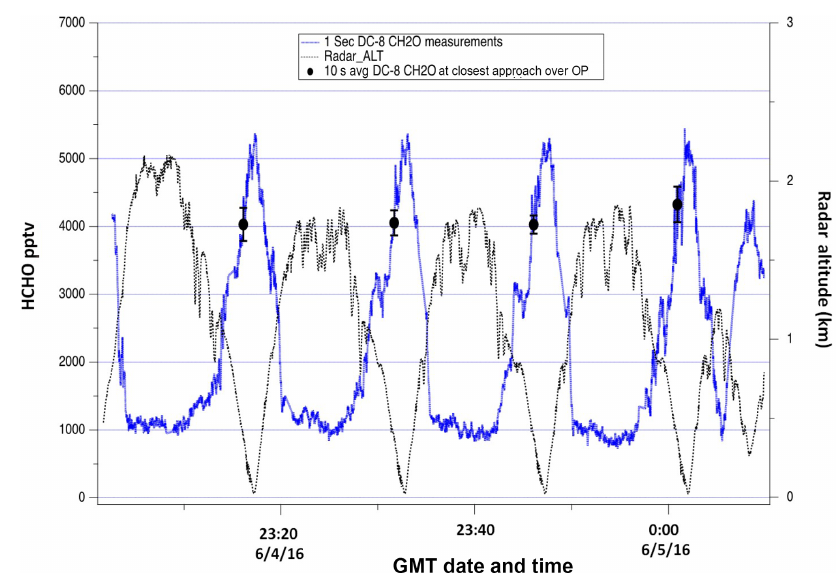
Figure 15. DC-8 CAMS HCHO mixing ratio measurements over Olympic Park on 4 June. The continuous blue profiles show the 1s HCHO data while the black points with error bars show the 10s average and standard deviation of this data at points of closest approach above the Olympic Park site.